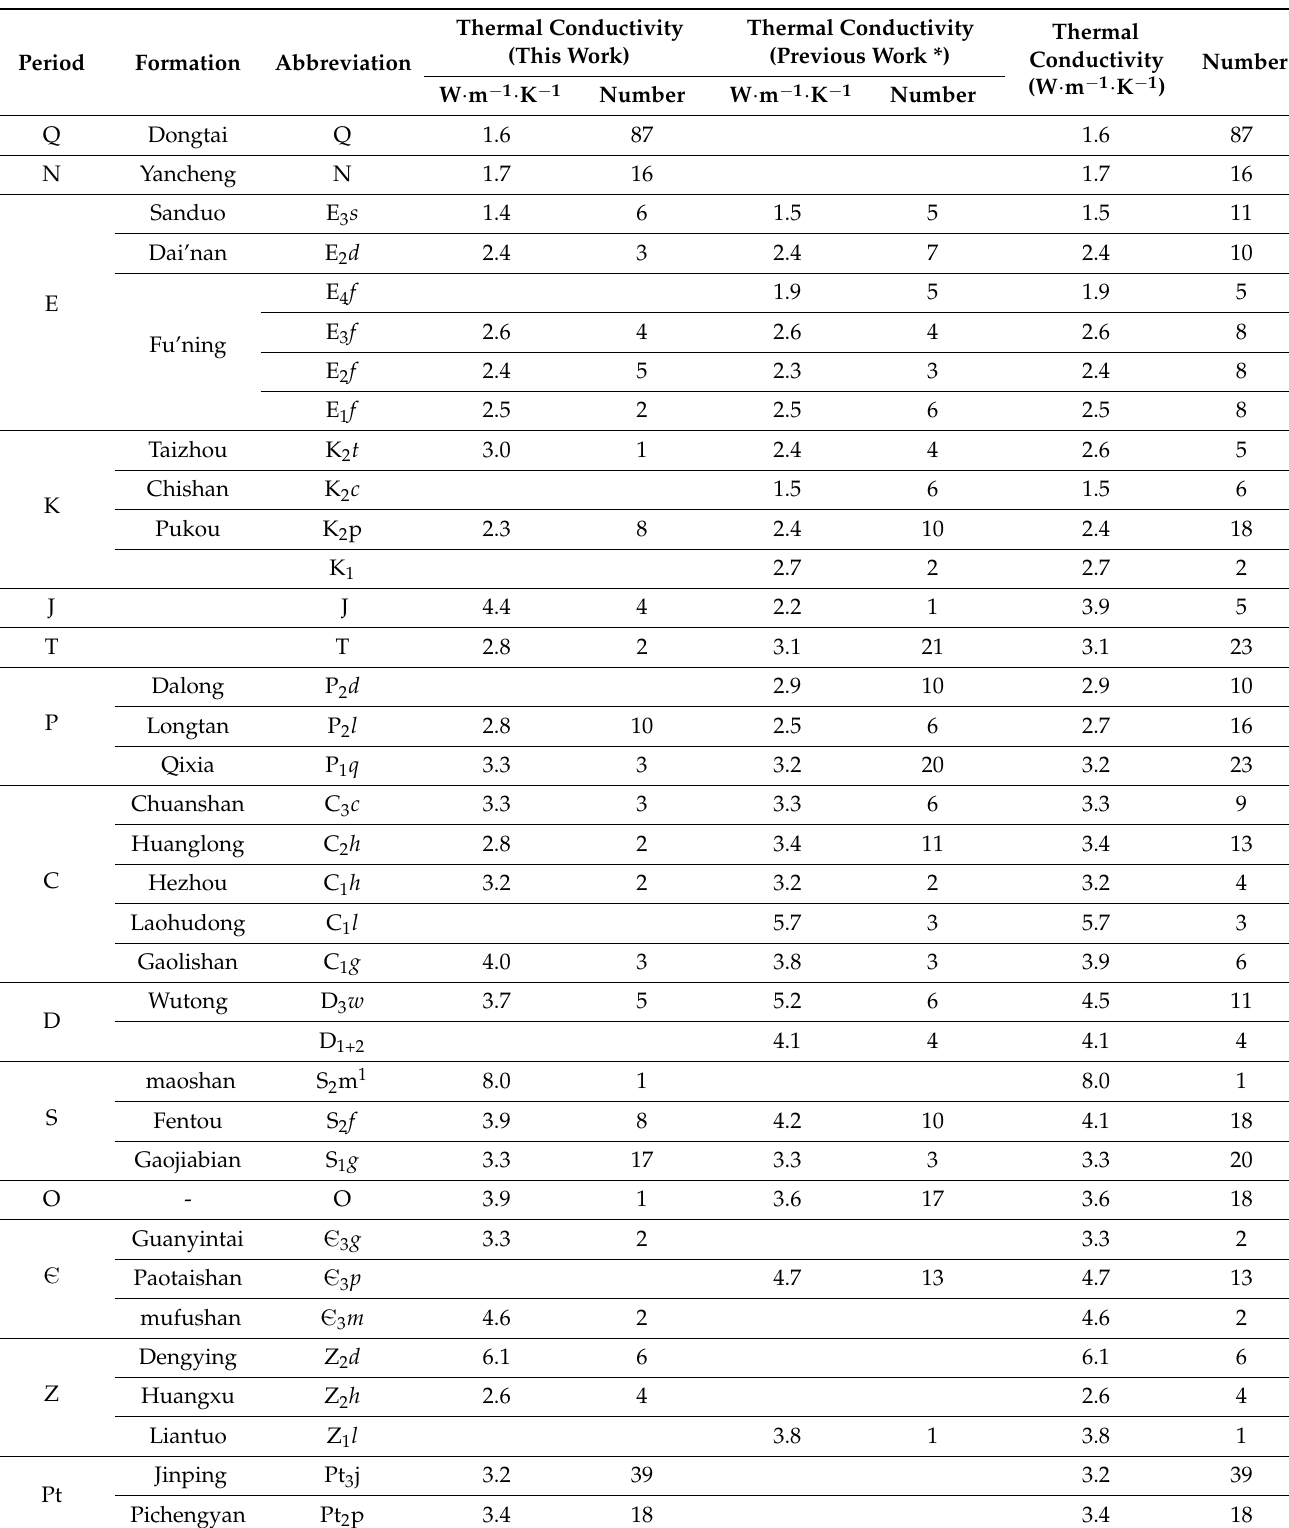
Table 1. Thermal conductivity of the formations in the North Jiangsu